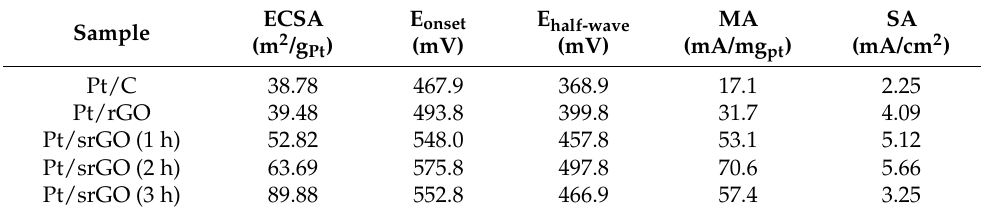
Figure 5. ( a ) CV curves of Pt/rGO, Pt/srGO (2 h), and Pt/C in N 2 -saturated (black lines) and O 2 -saturated (red lines) 0.5 M H 2 SO 4 at a scan rate of 20 mV/s. ( b ) CV curves of the catalysts in N 2 -saturated 0.5 M H 2 SO 4 at a scan rate of 20 mV/s. ( c ) Polarization curves of that catalysts in O 2 -saturated 0.5 M H 2 SO 4 at a scan rate of 5 mV/s and GCE rotational speed of 1600 rpm. ( d ) Mass and specific activities of the catalysts at 0.4 V vs. Ag/AgCl. Table 3. ECSA, E onset , E half-wave , Ma and SA of the